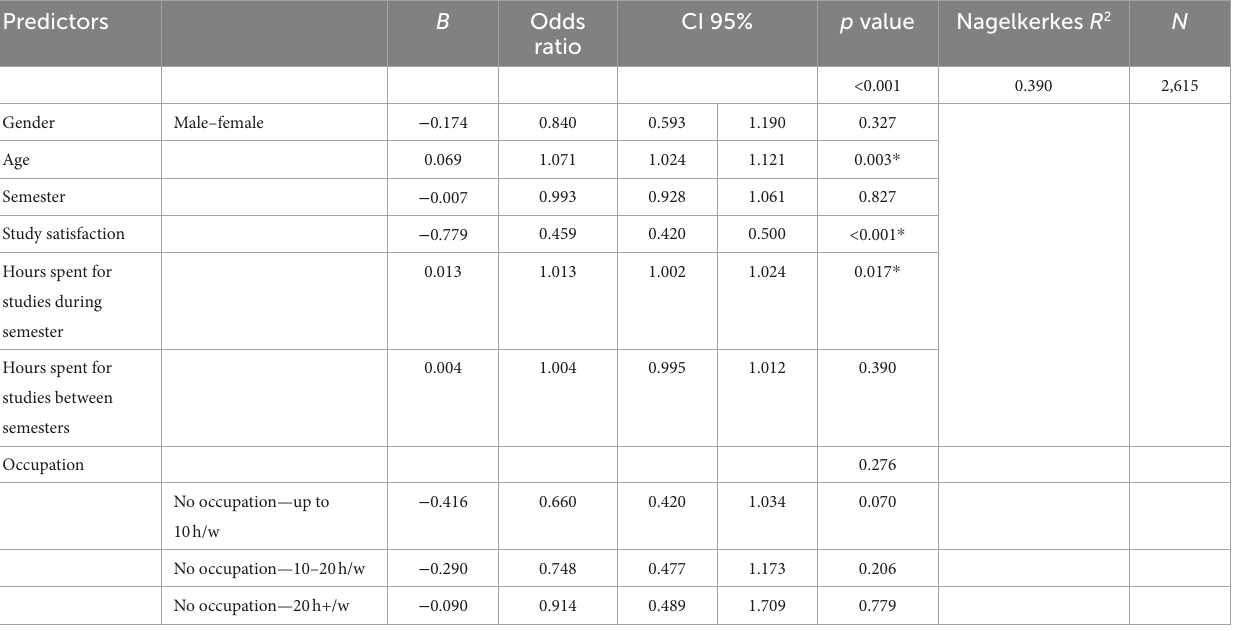
TABLE 5 Binary regression model for cynicism.